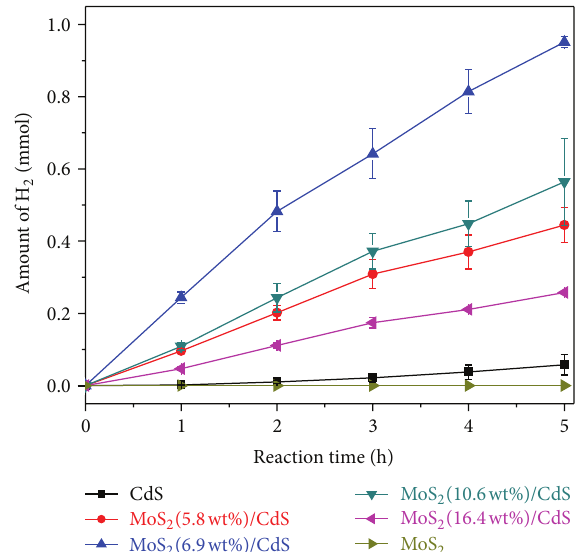
Figure 5: The time courses of photocatalytic H 2 production on MoS 2 /CdS with various MoS 2 ratios under visible light irradiation.